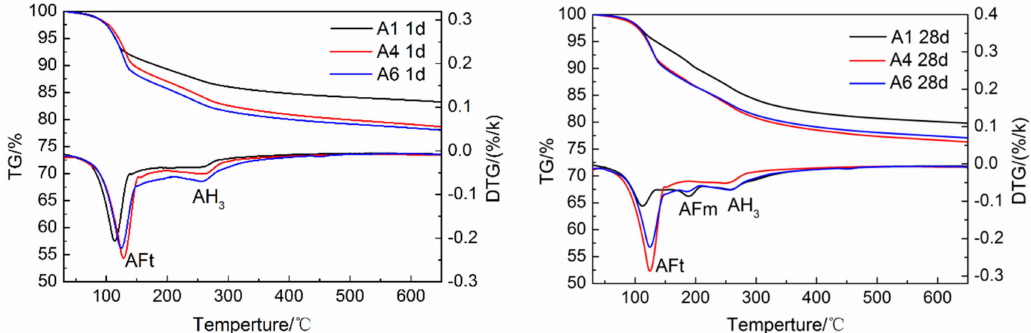
Figure 8. TG / DTG analysis of AMCSA hydration for 1 d and 28